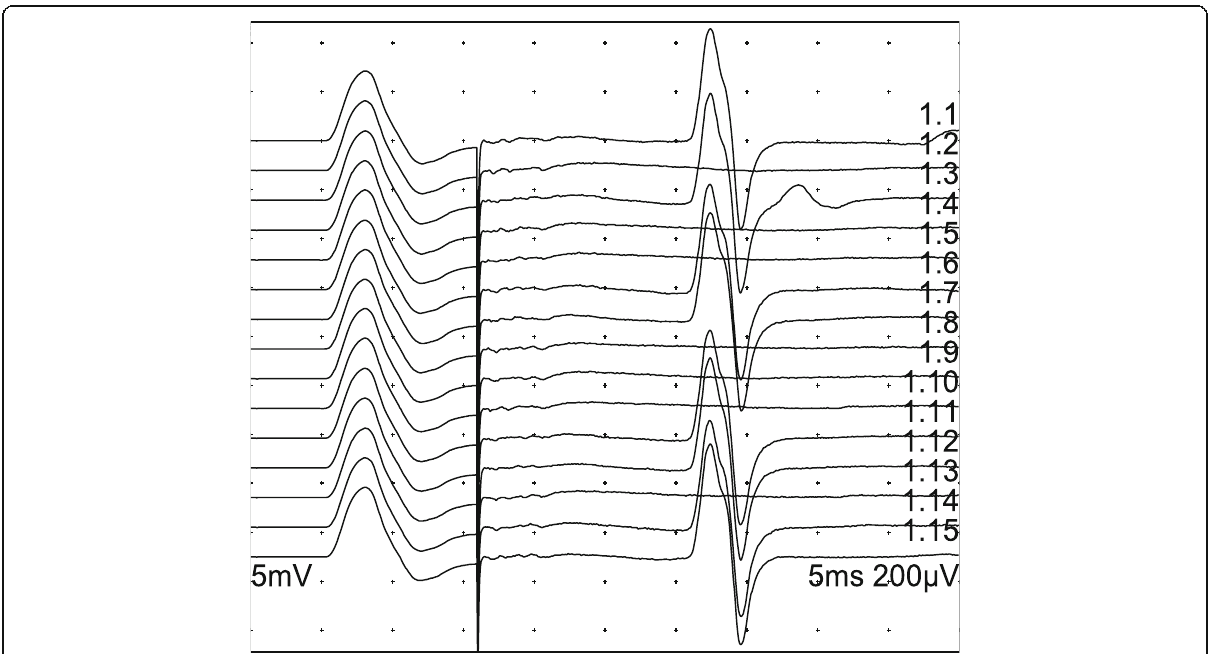
Fig. 2 Simple A-waves in the right median